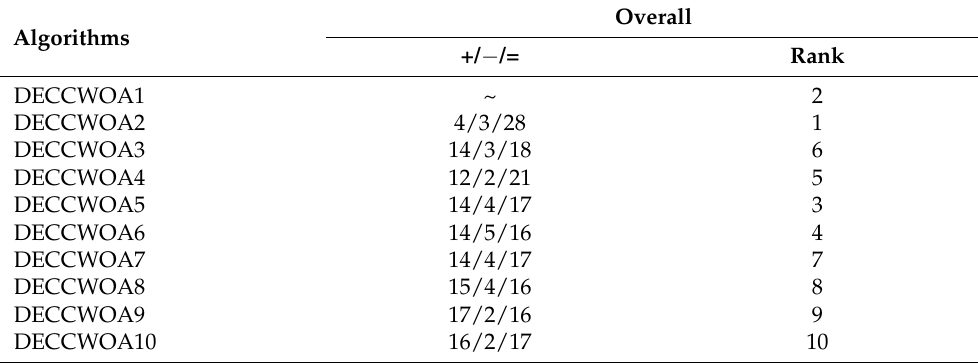
Table 3. Experimental results for analysis of different versions.